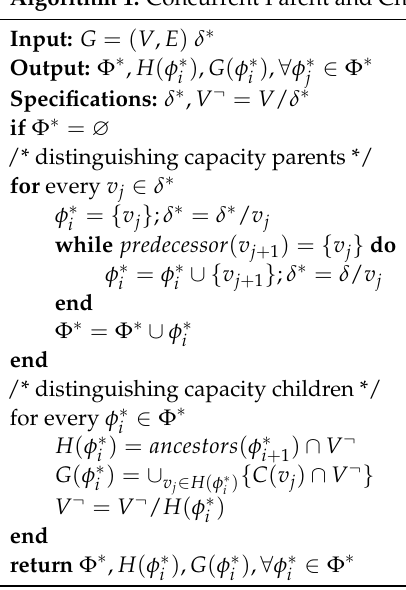
Algorithm 1: Concurrent Parent and Child Model algorithm CPCM ( G , δ ∗